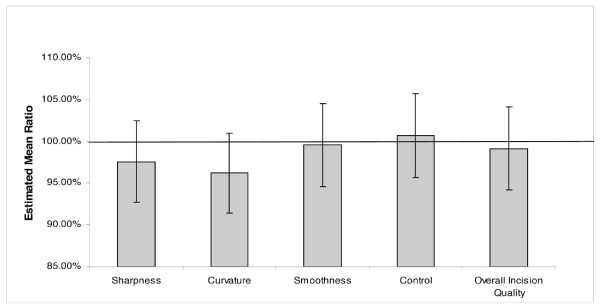
Silicon versus Diamond. The estimated mean ratios and confidence intervals for each characteristic assessed for the silicon and diamond knife comparison.